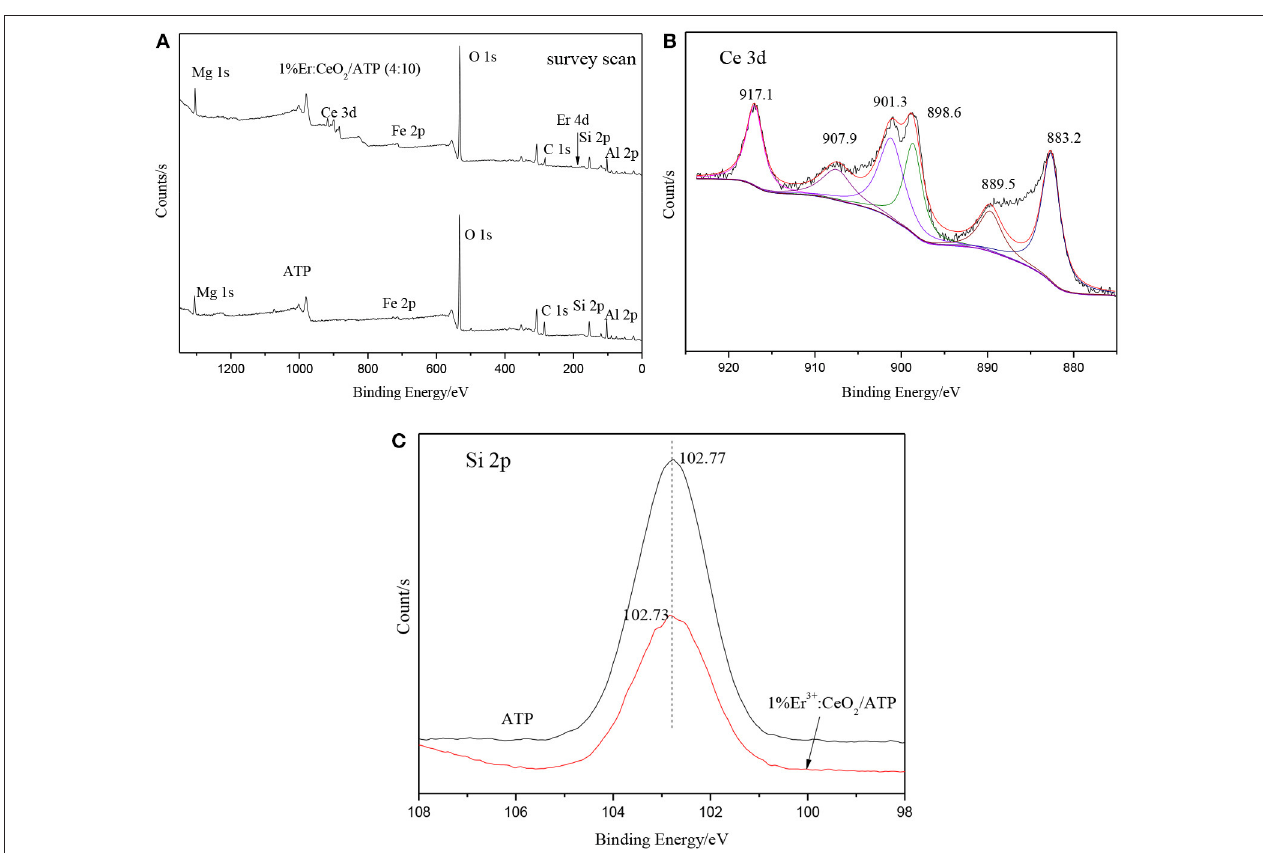
FIGURE 7 | XPS patterns of ATP, and 1%Er 3 + :CeO 2 /ATP (4:10), (A) Survey scan, (B) Ce 3d, and (C) Si 2p.